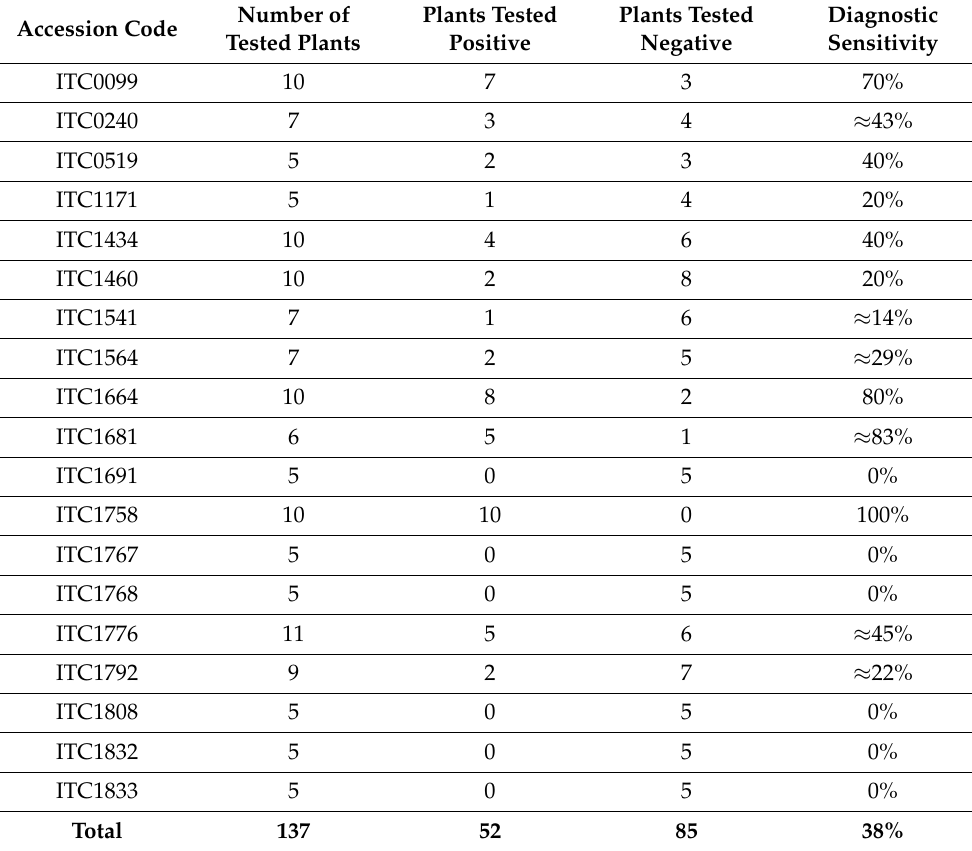
Table 1. BanMMV detection by IC-RT-PCR from corm tissue of infected in vitro plants (19